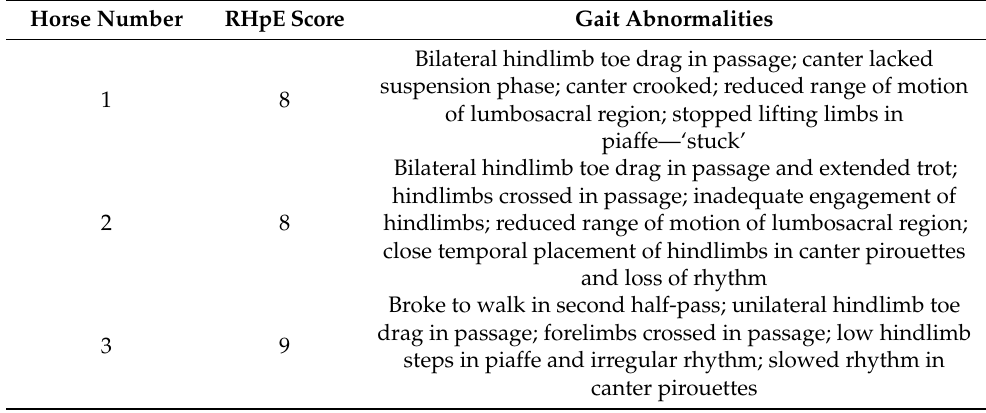
Table 1. Summary of gait abnormalities of three horses that had a Ridden Horse Pain Ethogram (RHpE) score of 8 or 9/24 when competing at the British Dressage Grand Prix National Championship.